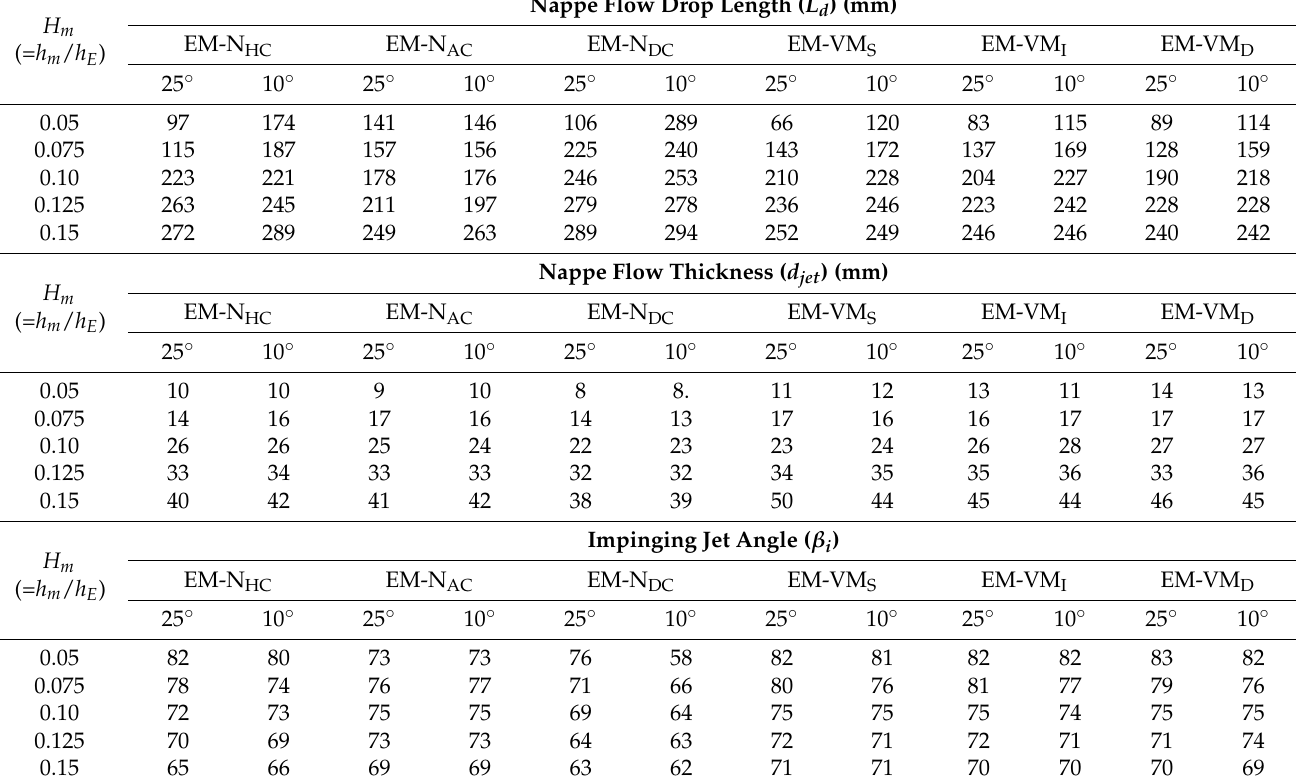
Table 5. Variation of drop length L d , nappe flow impinging jet thickness d jet and impinging jet angle β i concerning the normalized overtopping depth H m (= h m / h E ) ; for 25 ◦ landward slope and for 10 ◦ landward